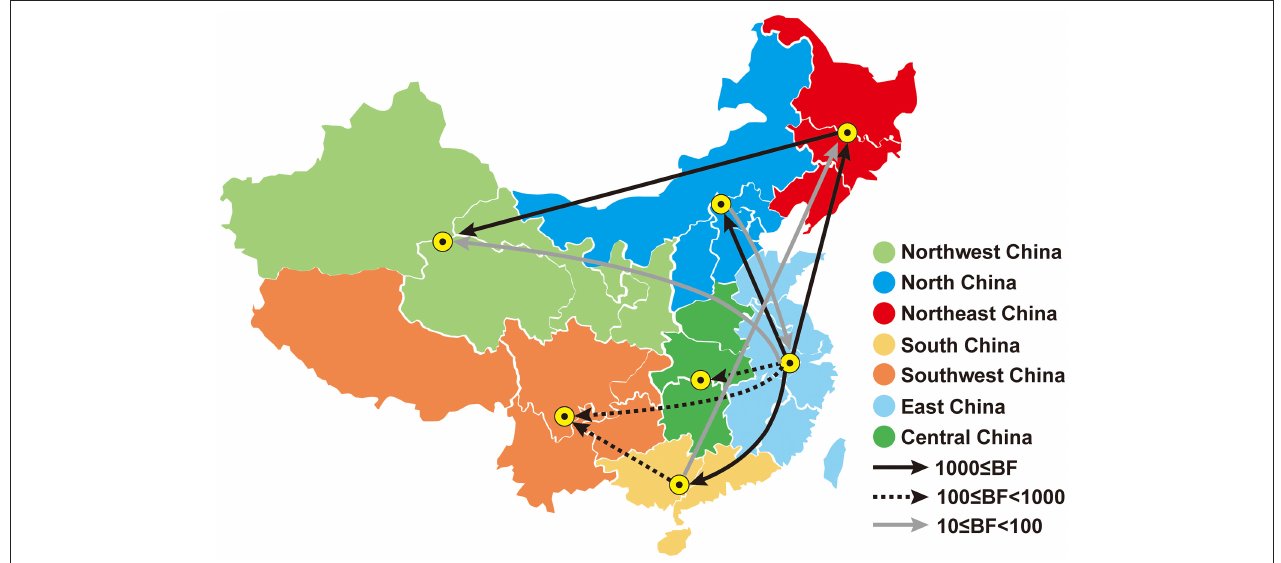
FIGURE 7 | Spatial diffusion of PPMV-1 isolates in China. Statistically supported migrations with Bayes factor (BF) > 3 are presented. Morphological characteristics of lines represents migration rates: black solid arrows, decisive support with BF ≥ 1,000; black dashed arrows, very strong support with 100 ≤ BF < 1,000; gray solid arrows, strong support with 10 ≤ BF <